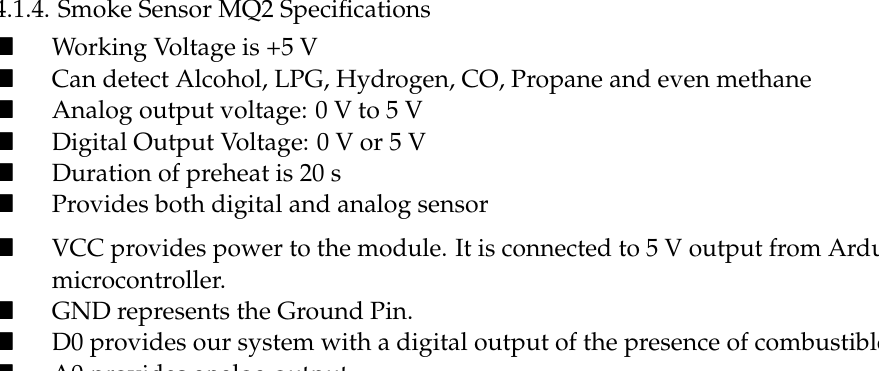
Figure 7. Specification and layout of Smoke Sensor